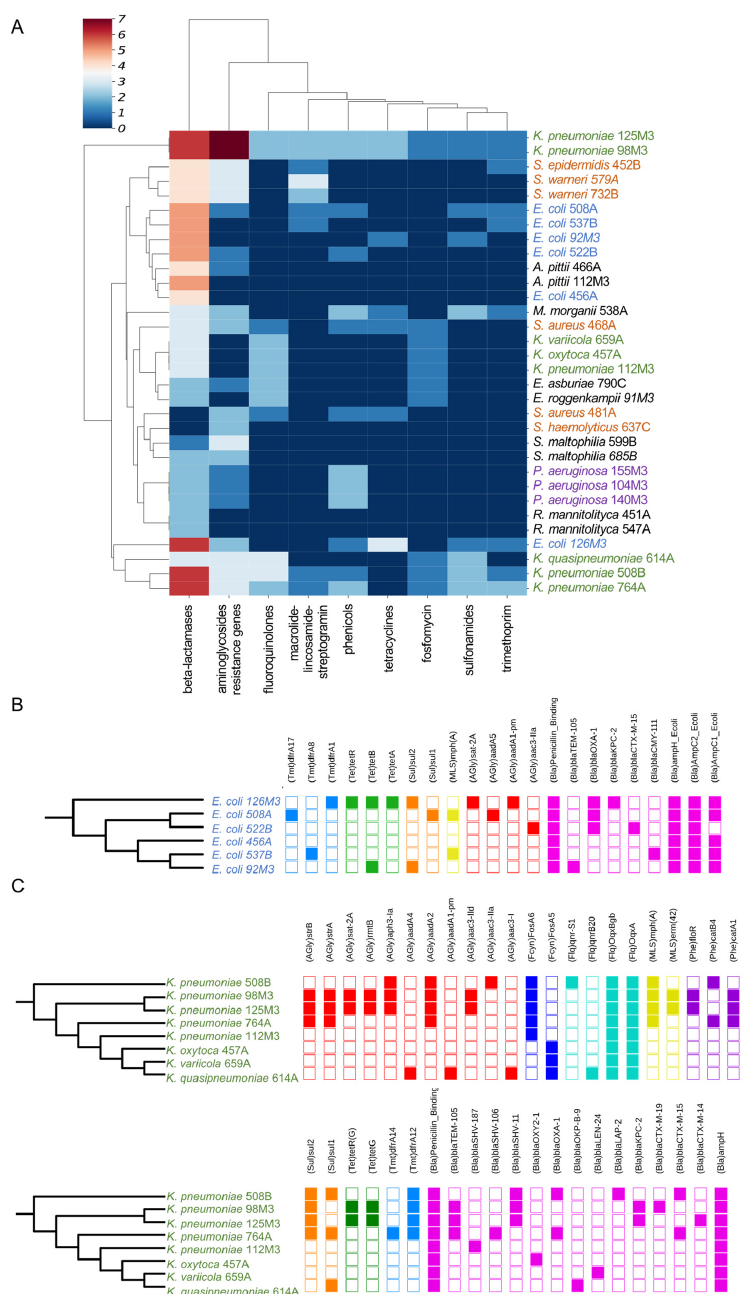
Figure 2. Identification of ARGs in sequenced genomes. ( A ) Heatmap showing the presence of ARGs identified by ARG-ANNOT indicating the number of each resistance gene per genome. Data were clustered using hierarchical mapping with Euclidian distance. The blue to red scale indicates the number of ARGs for each strain in each category, as indicated in the legend. The nucleotide sequences in ARG-ANNOT from different antibiotics classes are abbreviated as follows—AGly: aminoglycoside resistance genes; Bla: beta-lactamases; Fcyn: fosfomycin; Flq: fluoroquinolones; Gly: glycopeptides; MLS: macrolide–lincosamide–streptogramin; Phe: phenicols; Rif: rifampin; Sul: sulfonamides; Tet: tetracyclines; and Tmt: tri-